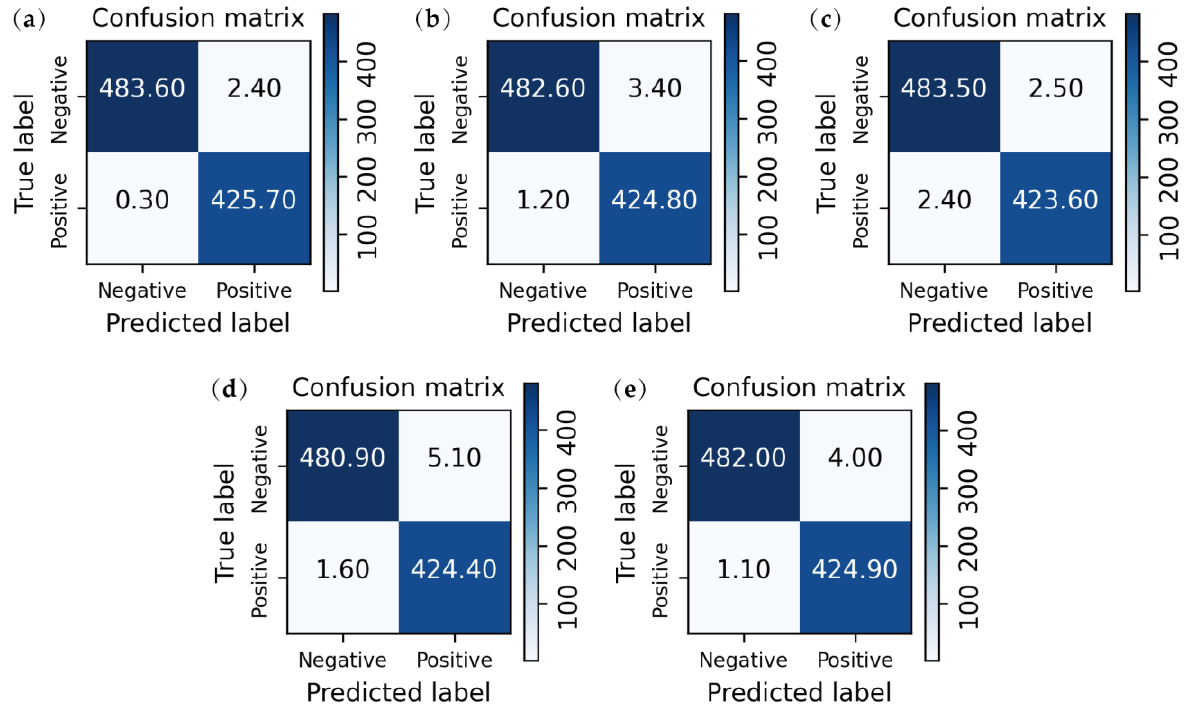
Figure 11. Average confusion matrices for models 1–5 in Table 6, each represented by its correspond- ing sub-figure ( a – e ).